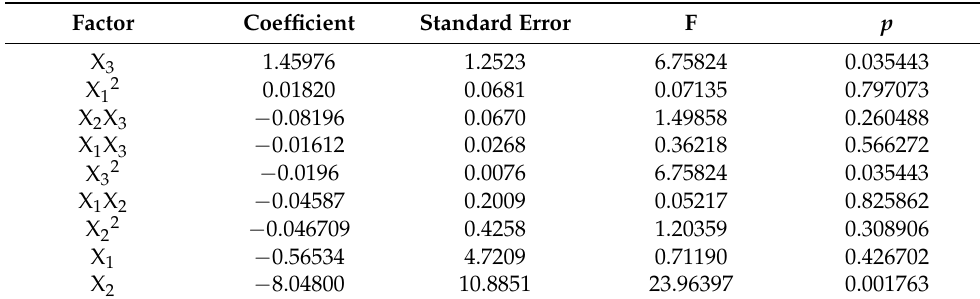
Table 4. Significance of regression coefficients of the